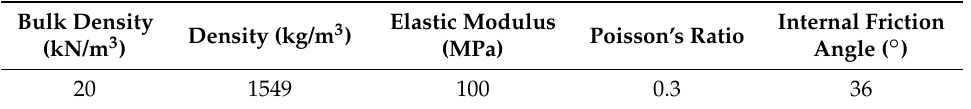
Table 1. Properties of the soil in the model test.